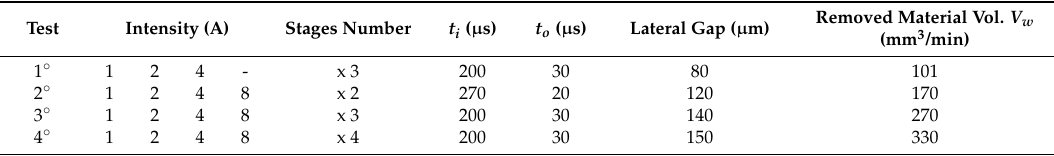
Table 5. Roughing parameters for the extruded MoCuSi.